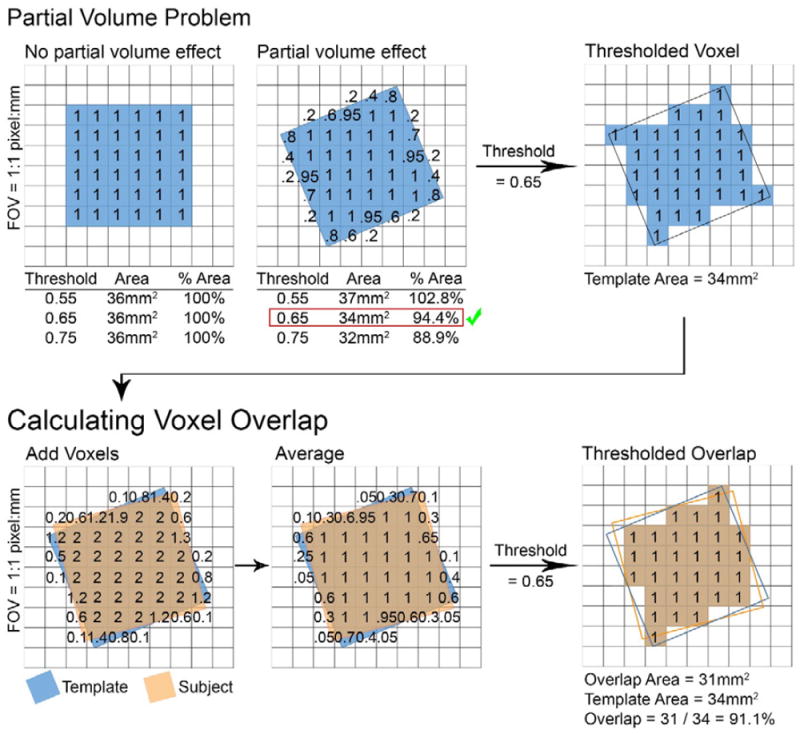
Upper panel: A schematic representation of the ‘partial
volume problem’ is depicted. On the left, a blue 6 mm × 6 mm 2D
voxel is orthogonal to the Field-of-View (FOV; i.e., unrotated). The voxel
occupies 100% of the 2D pixel space in every pixel location, and thus,
every location has a pixel intensity value = 1 (area = 36
mm2) at all pixel intensity threshold levels (i.e., no partial
volume effect). In the upper middle panel, the 2D voxel is rotated with respect
to the FOV, thus creating a ‘partial volume effect.’ Along the
edges of the voxel, pixel intensity values range between 0 and 1. Thus,
depending on the pixel intensity threshold (i.e. the threshold beyond which the
voxel is deemed present [vs. not present] in each pixel
location), the voxel area will range between 37 mm2 (102.8%
of ‘true’ template voxel area; i.e., its area when orthogonal to
the FOV or 36 mm2) and 32 mm2 (88.9%). The user
should select the pixel intensity threshold that corresponds to closest to,
without exceeding, 100% of the unrotated area (i.e., 36 mm2).
The appropriate pixel threshold is 0.65 which corresponds to a thresholded voxel
area of 34 mm2 (figure on the upper right) or 94.4% of the
template area (i.e., 34 mm2/36 mm2). The user should
report voxel overlap results that correspond to the selected pixel intensity
threshold. Lower panel: The analytic strategy for calculating voxel
overlap with the template voxel (i.e., voxel placement
‘accuracy’) is depicted. The binarized subject voxel is added to
the binarized template voxel in template space (after coregistration using
‘AVP_Overlap’) such that pixel values sum. At every pixel
location, an average pixel value is calculated and thresholded (at the selected
pixel intensity threshold: 0.65). The overlap area is quantified and expressed
as a percentage of the template area (using the same pixel intensity threshold:
0.65). In this example, the thresholded overlap area is 31 mm2, which
is divided by the template area (34 mm2), and expressed as a
percentage: 91.1% voxel overlap. This example depicts calculation of
voxel placement accuracy: subject voxel overlap percentage with the template
voxel. However, the same steps are repeated for between-subject overlap and
within-subject overlap, with one difference – only subject voxels are
used for those metrics. The template voxel is not included in the calculation of
between- or within-subject overlap, only for calculation of voxel placement
‘accuracy’.